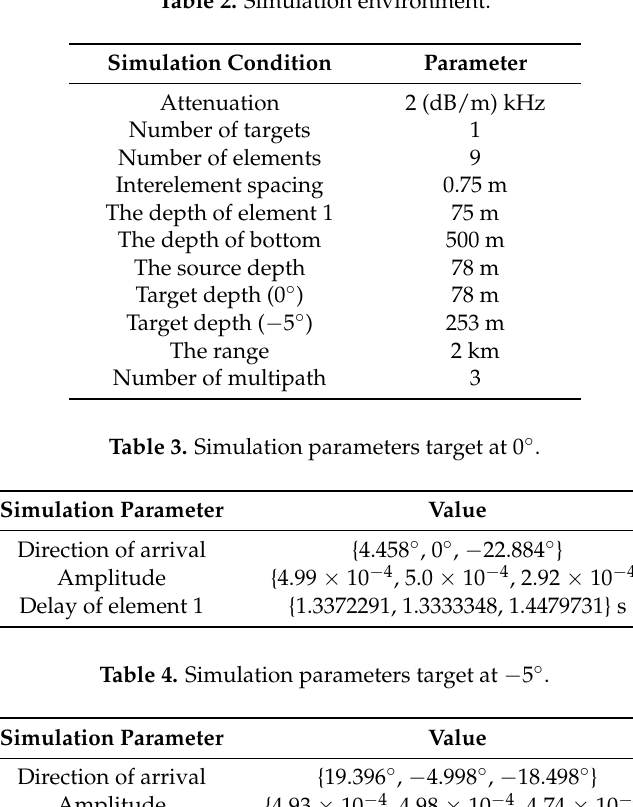
Table 2. Simulation environment.